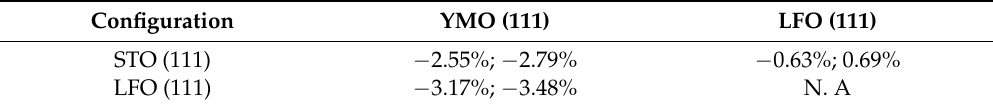
Table 3. Theoretical lattice mismatch ε , between component compounds, along two orthogonal in-plane directions when the substrate is (111)-STO. Two orthogonal in-plane directions are [1-10] and [11-2]. In this table, lattice mismatch is calculated by assuming lattice constants of YMO and LFO in pseudo-cubic setting. The lattice constants of LFO and YMO in pseudo-cubic setting are 3.93 Å and 3.83 Å, respectively. N. A represents not